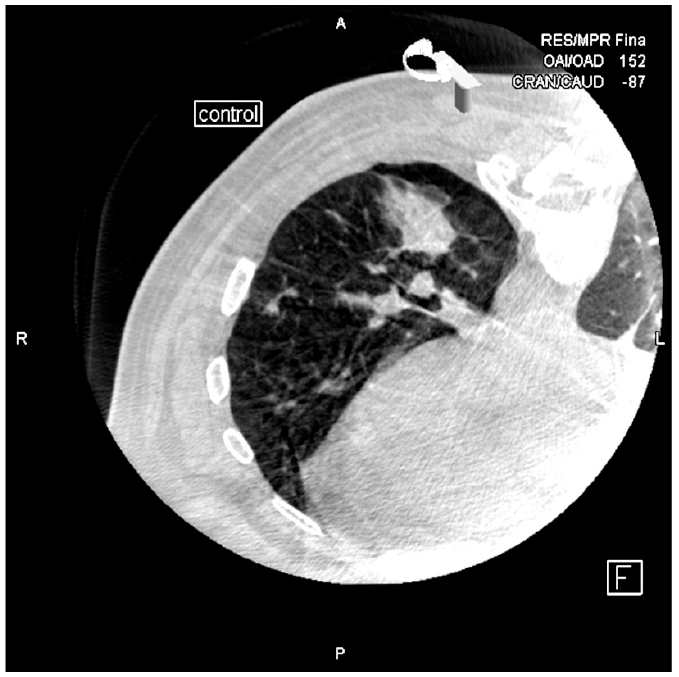
Figure 7. Alveolar hemorrhage and small pneumothorax are observed after removing the needle.